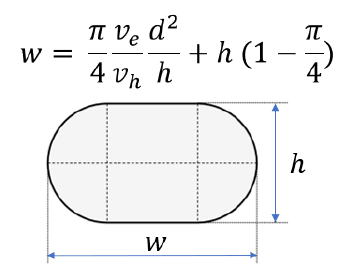
Figure 4. Scheme of the assumed cross-section of the deposited strand. v e is the extrusion speed (i.e., the exiting velocity of the extrudate from the nozzle), v h the printing speed (i.e., the linear velocity of the EE), d the diameter of the nozzle, and h the high of the deposited strand, which is often assumed to be equal to the distance between the nozzle and the substrate z